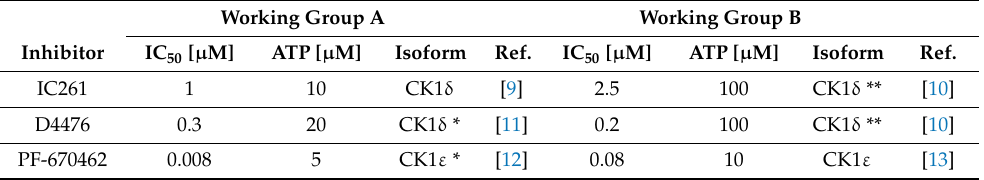
Table 1. Interlab variation of IC 50 values for CK1-specific inhibitors. Working Group